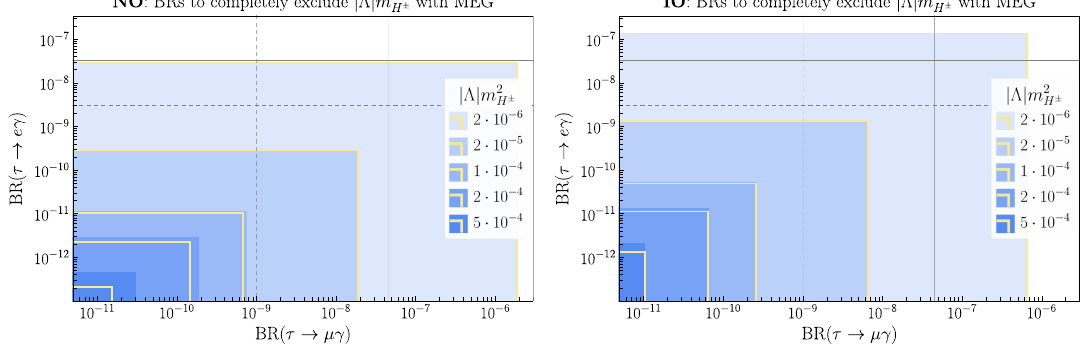
Figure 8. Branching ratios for τ decays within yellow rectangular border allow to exclude the whole ω 22 r plane for a specified photon factor Λ m 2 with MEG bounds on µ H ± − | | blue rectangles correspond to the case of infinitely precise experimental bound. To exclude larger photon factor values, bounds on µ eγ have to be improved leading to the same rectangles up to → an appropriate scaling of Λ m 2 and axes, as mentioned in the text. Gray solid lines correspond H ± | | to current experimental bounds, gray dashed lines — to the planned